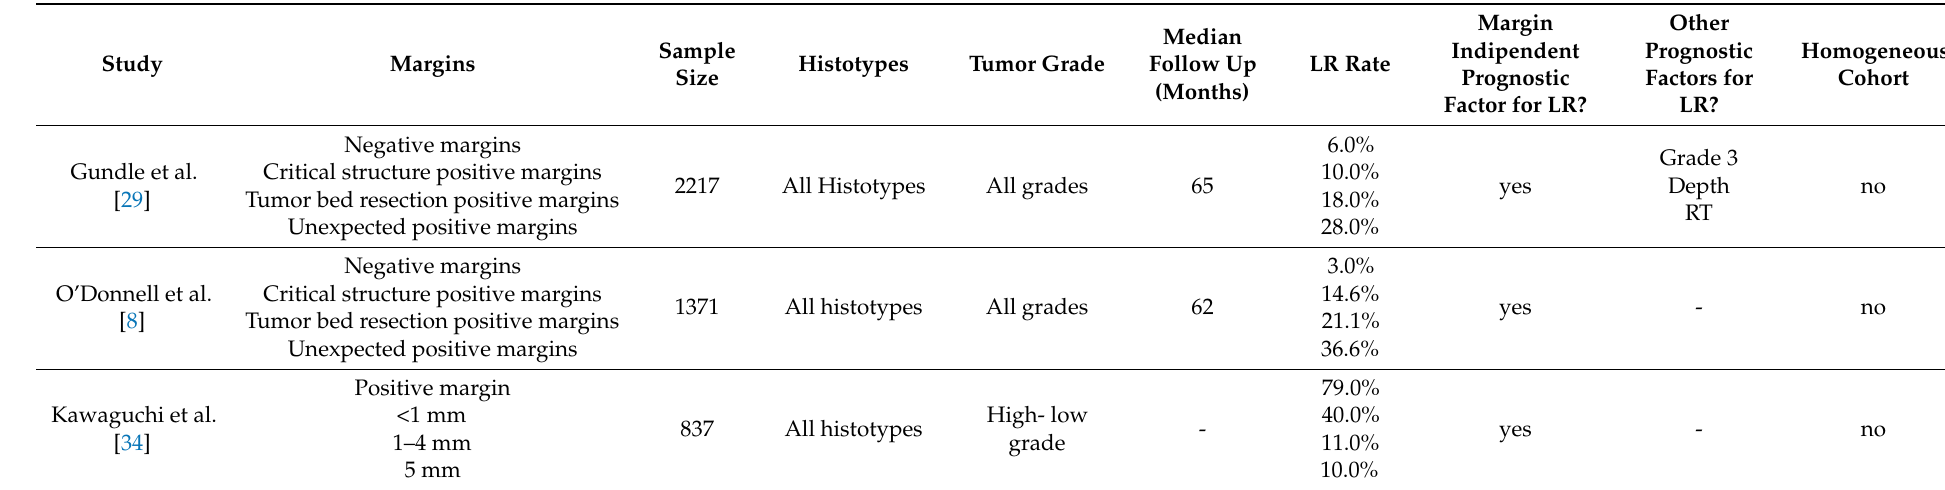
Table 5. Review of the literature. Studies reporting margins based on TMCC